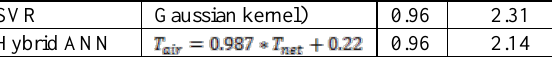
Table2. SVR and Hybrid Neural Network models and their statistical data